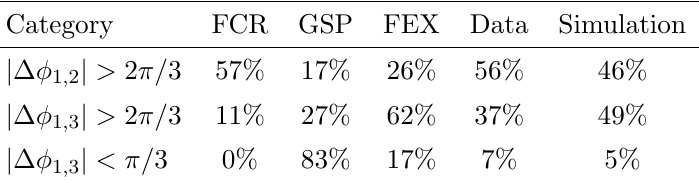
Table 2 . Relative contributions of the three heavy-(cid:13)avor production sub-processes in pythia 6 to the jet pair categories, as well as the relative abundance of the three categories in data and simulation.